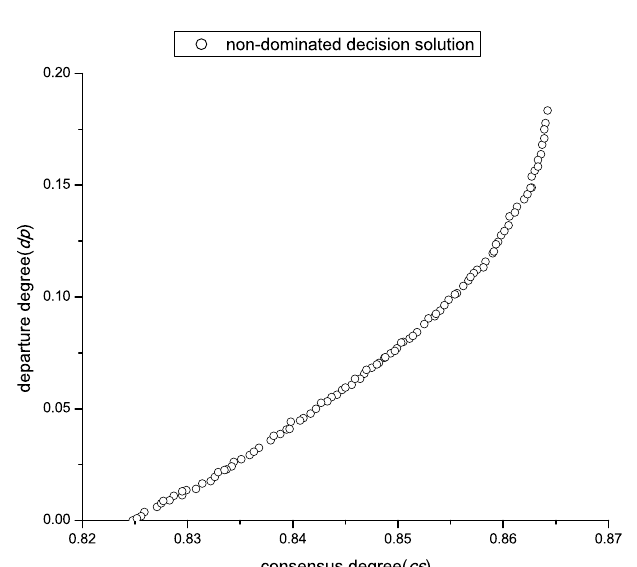
Figure 3: Obtained non-dominated decision solutions of the multi-objective optimization problem of the deci- sion preferences given by DMs after the first round of interactive procedure.